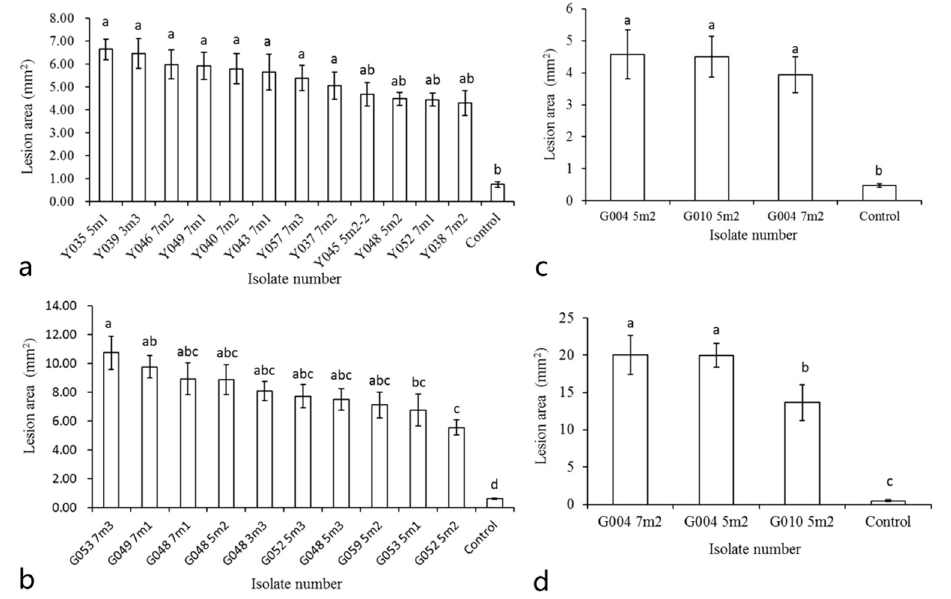
Figure 4. Mean ( ± SD) lesion area (mm 2 ) developed following inoculation of Prunus armeniaca and Prunus divaricata excised leaves and fruits with di ff erent isolates of Wilsonomyces carpophilus . Means that were significantly di ff erent based on honest significant di ff erence (HSD) analysis are labeled with di ff erent letters ( n = 10, p = 0.05). ( a ) P. armeniaca leaves; ( b ) P. armeniaca fruits; ( c ) P. divaricata leaves; ( d ) P. divaricata